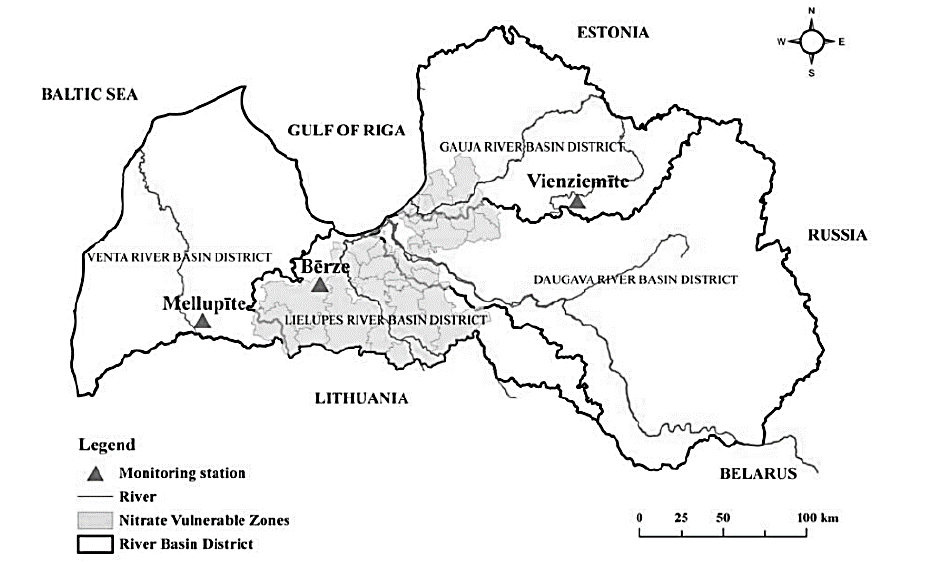
Fig. 1. Location of the monitoring sites at Berze, Mellupite and Vienziemite